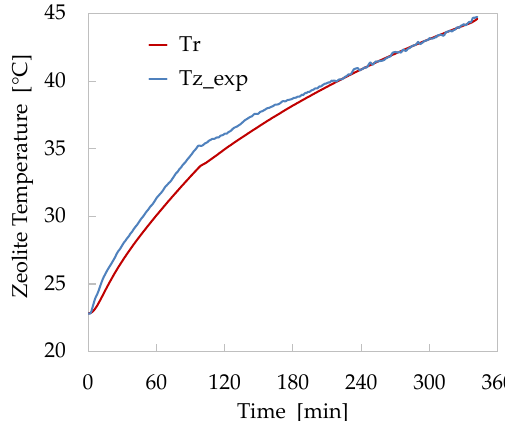
Figure 10. Comparison of numerical (red) and experimental (blue) temperature trends of zeolite bed for the desorption Test 3.